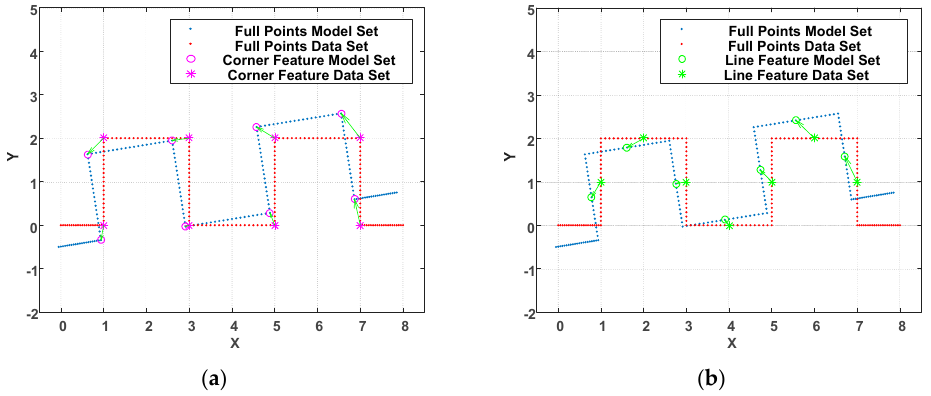
Figure 6. Illustration of feature-based point cloud registration. ( a ) Corner features are matched to corresponding corner features ( b ) Line features are matched to corresponding line features.